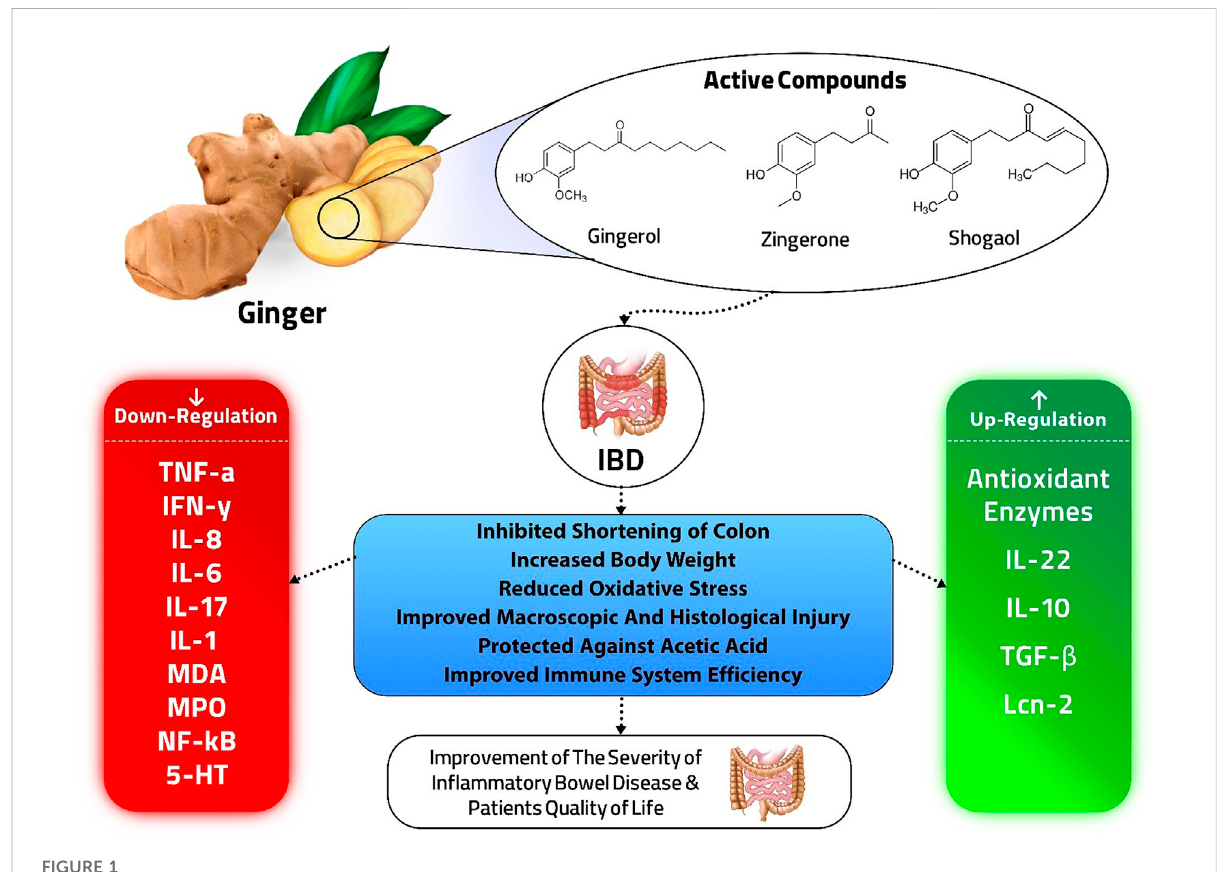
FIGURE 1 Underlying mechanisms of ginger in in fl ammatory bowel